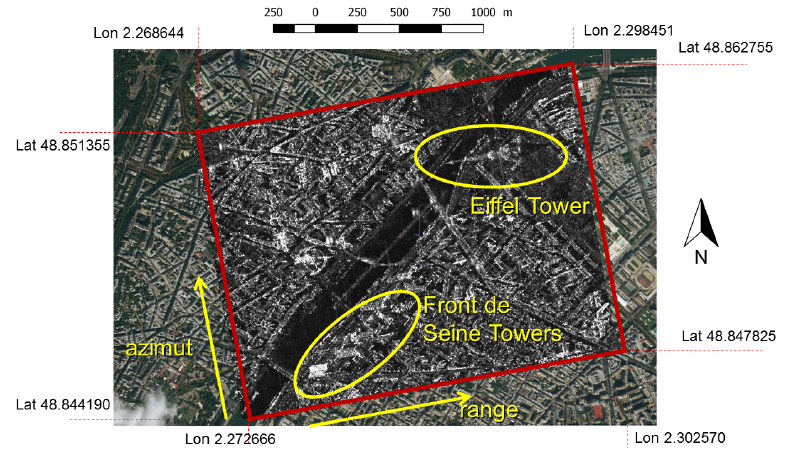
Figure 2. Geographical location of the studied area and the SAR